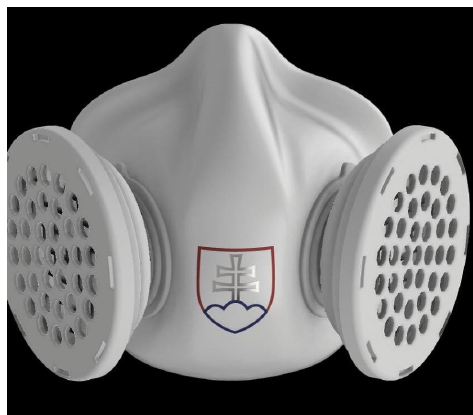
Figure 3. The 3D printed half-face mask.